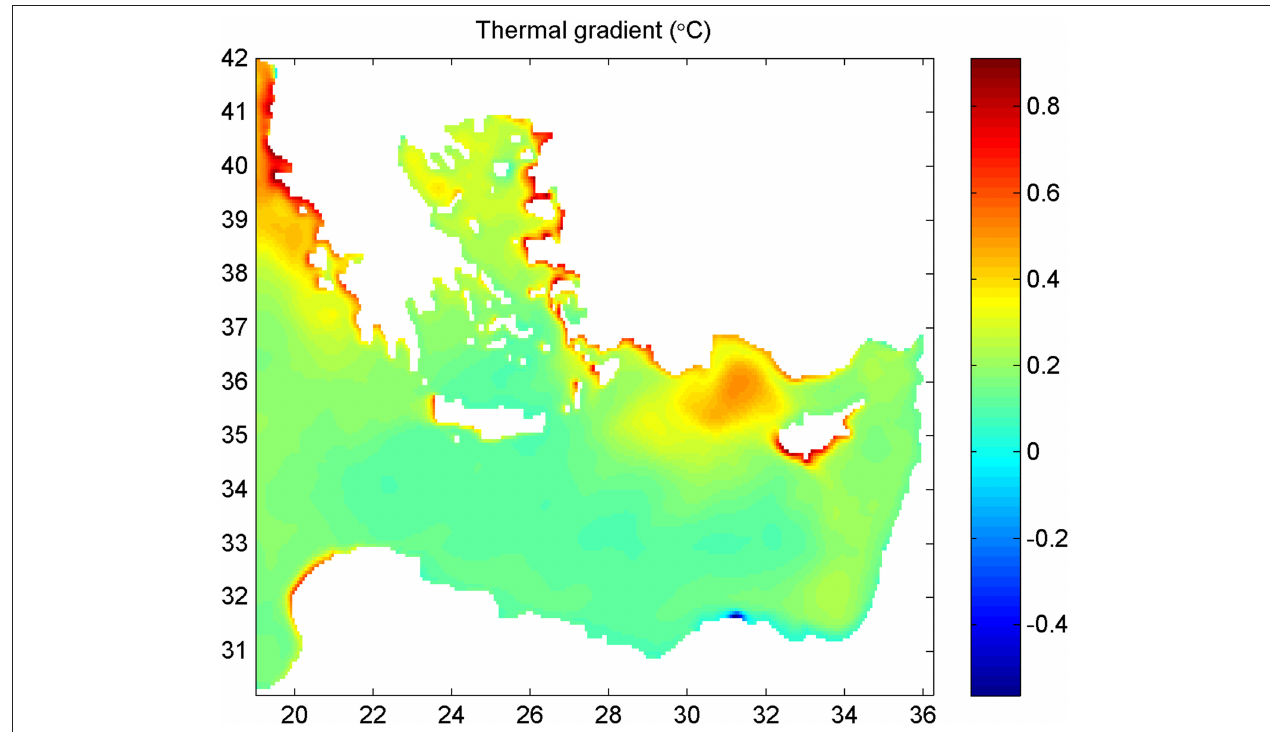
FIGURE 6 | Mean thermal gradient between 1.5m and 7. 9m depth for the Eastern Mediterranean during 2006-2015.